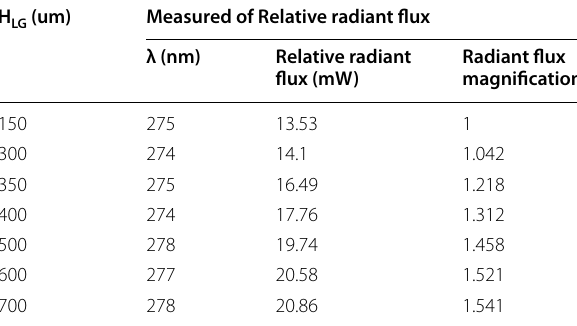
a thickness of 150 μm. Figure 7 illustrates the UV-C LED